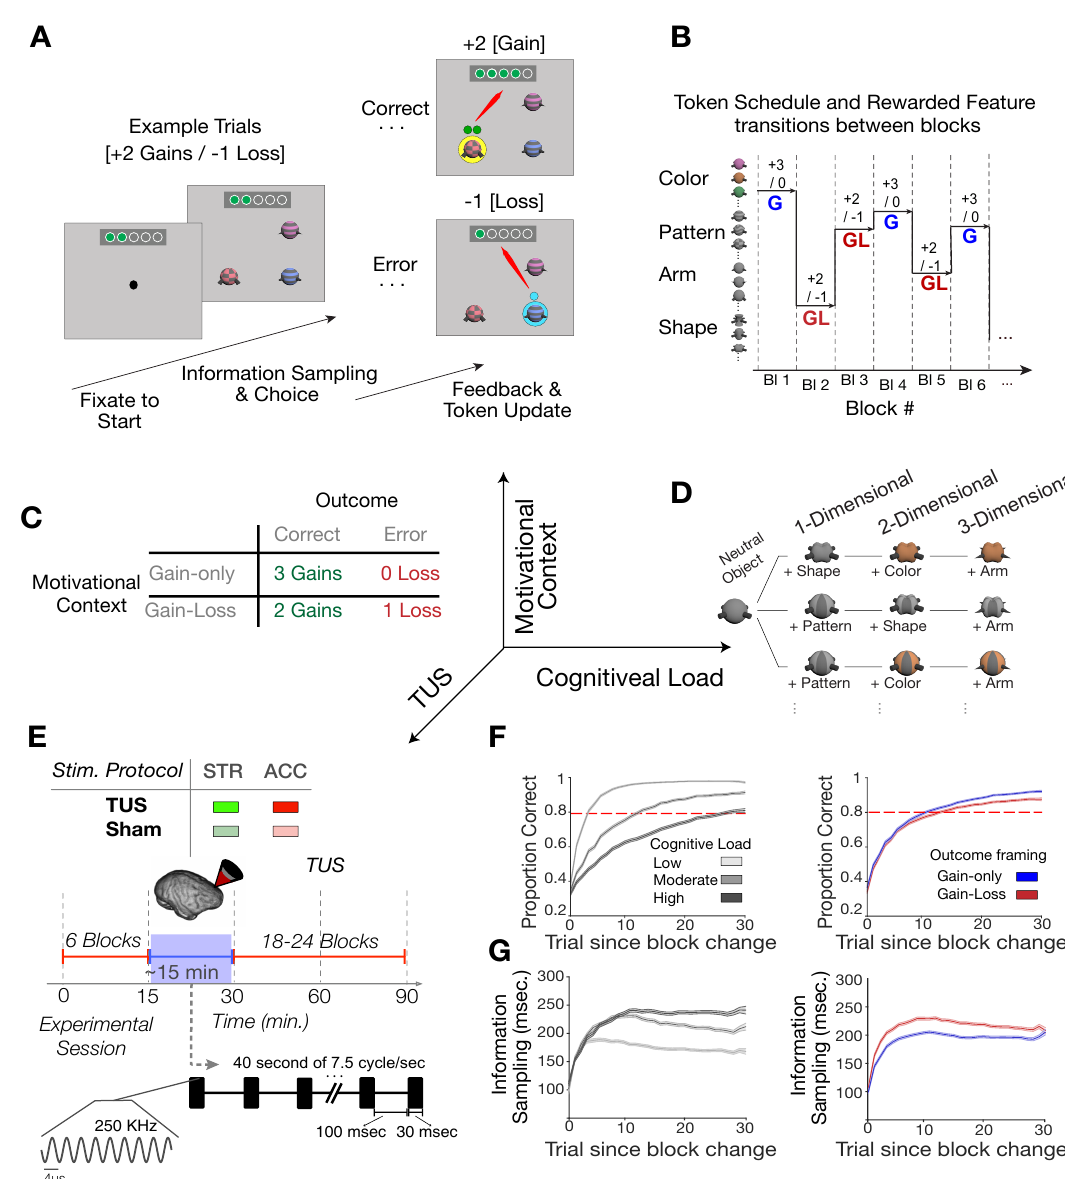
Fig 1. Task paradigm and TUS protocol. AU : AbbreviationlistshavebeencompiledforthoseusedinFigs 1 (cid:0) 3 andS 3 ; S 8 ; andS 11 : Pleaseverifythatallentriesarecorrect : ( A ) A trial started with central gaze fixation and appearance of 3 objects. Monkeys could